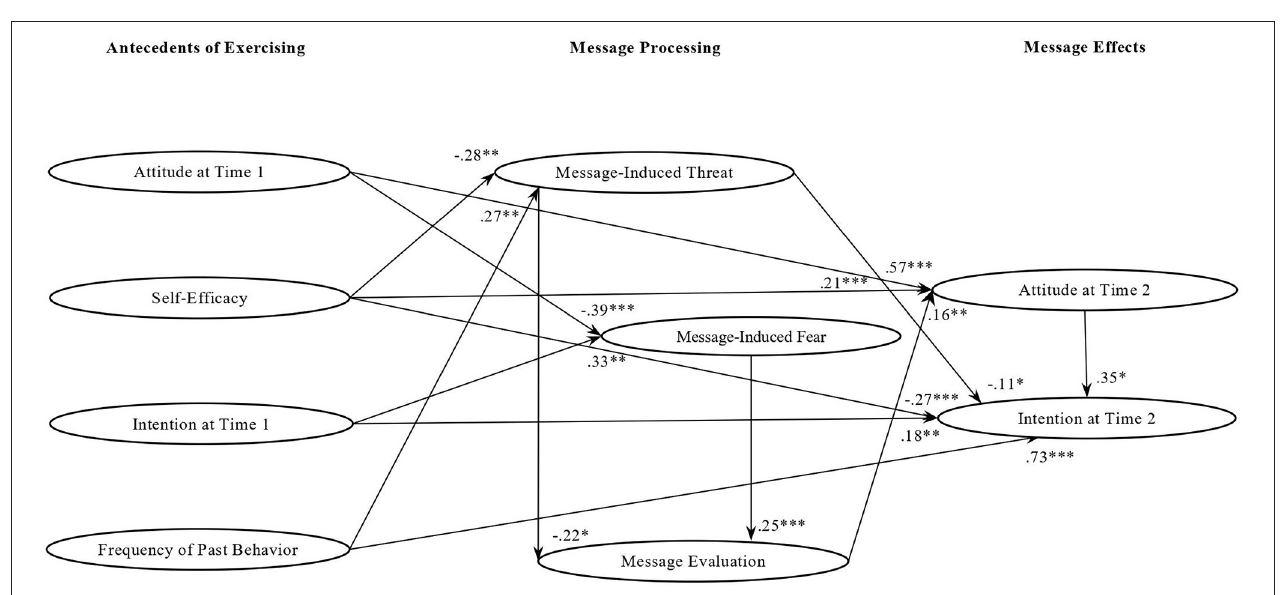
FIGURE 4 | Standardized factor loadings of the relationships among study variables in the loss message group. * p < 0.10; ** p < 0.05; *** p < 0.001.